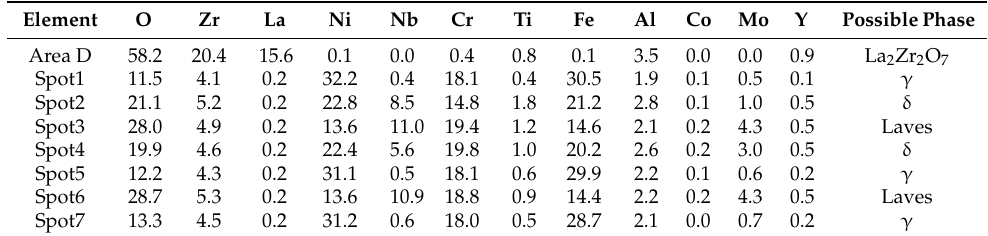
Figure 3. XRD patterns of the laser clad coating. Table 3. EDS results of the coating at different positions of Figure 2 (at.%).